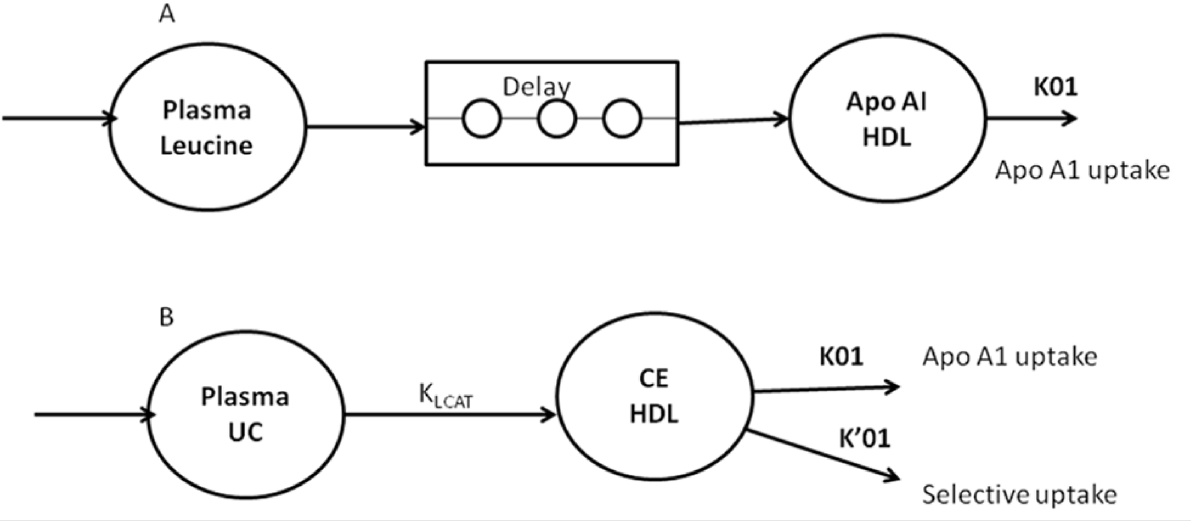
Fig 1. Monocompartmental model used for the modeling of apolipoprotein AI (apoAI) (A) and HDL cholesteryl ester (B) turnover in dogs. UC, unesterified cholesterol; CE, cholesteryl ester; k 01 , apoAI uptake; k 01 ’ , CE selective uptake; k LCAT , cholesterol esterification rate.